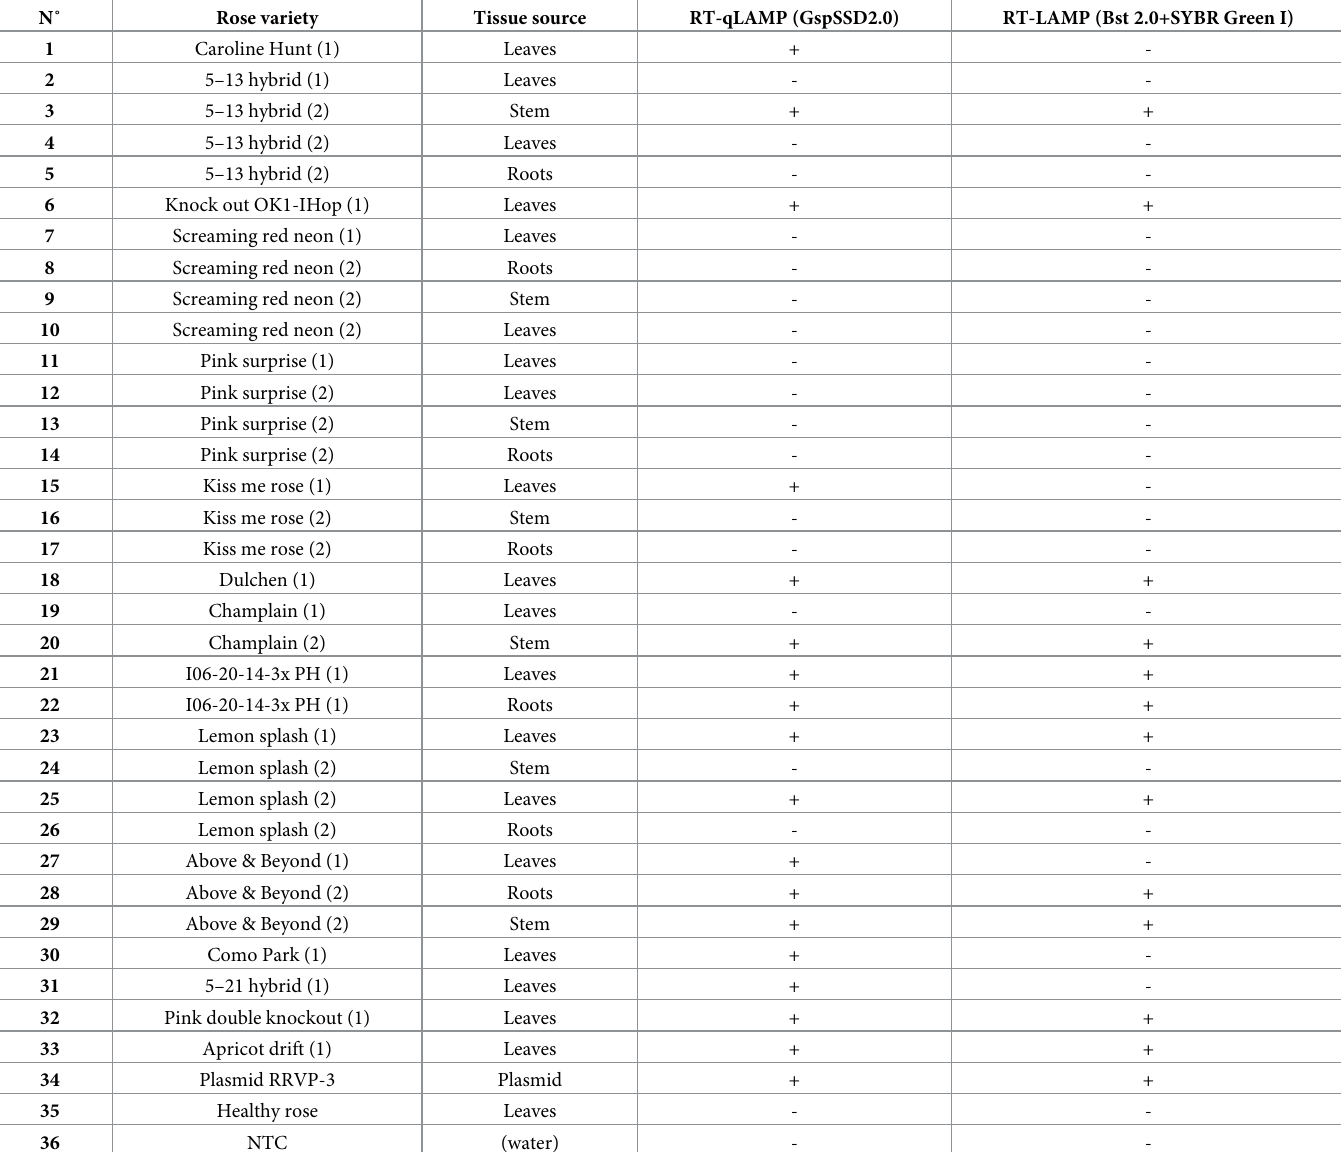
Table 3. Side-by-side comparison of RRV-P3 RT-qLAMP using GspSSD2.0 DNA polymerase and colorimetric RRV-P3 RT-LAMP using Bst 2.0 DNA polymerase with SYBR Green